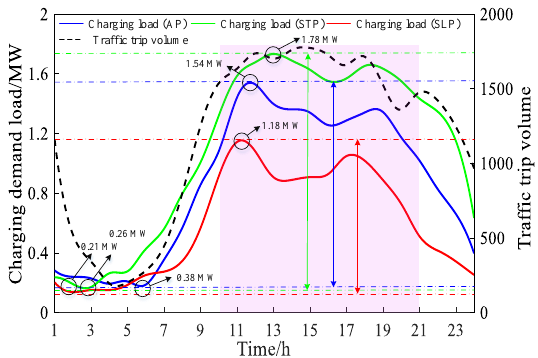
Figure 15. Comparison of charging demand load among AP, SLP and STP path strategies.